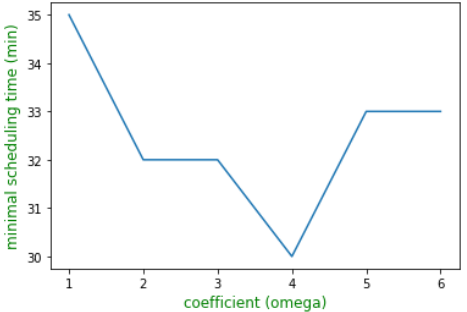
ff ect of coe ffi cient ω on minimal scheduling time for a random initial sequence. Figure 3. The effect of coefficient  on minimal scheduling time for a random initial sequence. Figure 3. The e